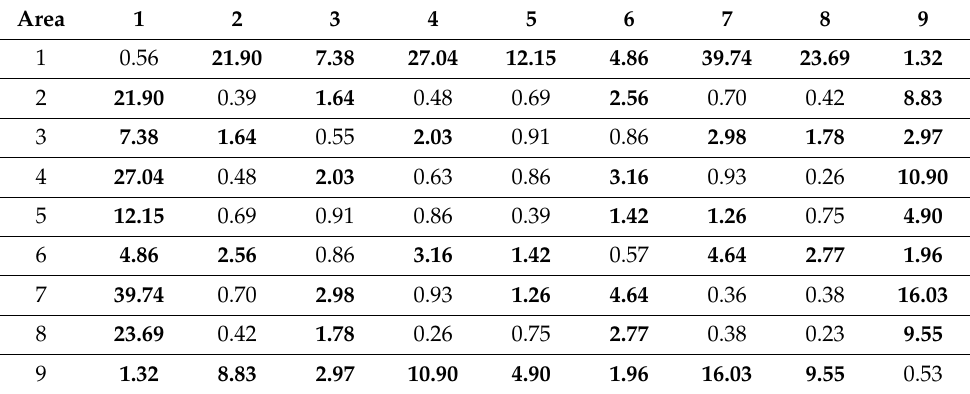
Table 1. Ratio between actual K F (in formula 2) and critical K F , 5% (5% significance)